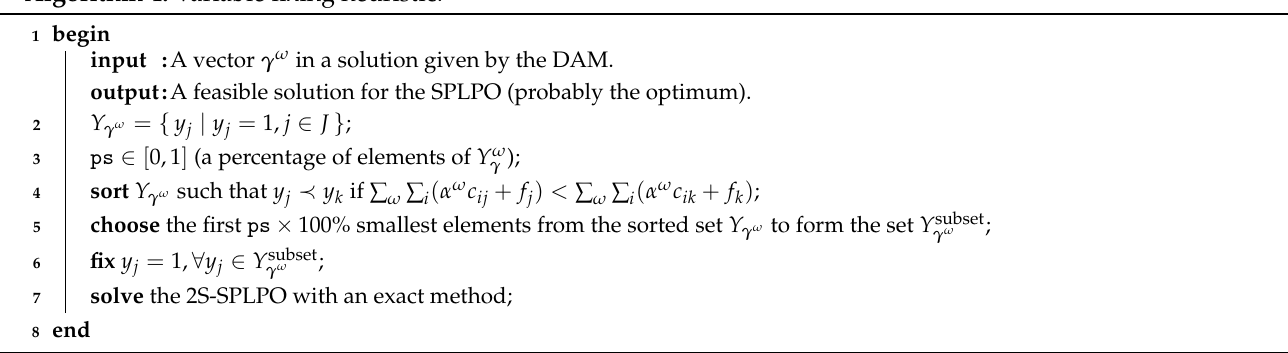
Algorithm 4: Variable fixing